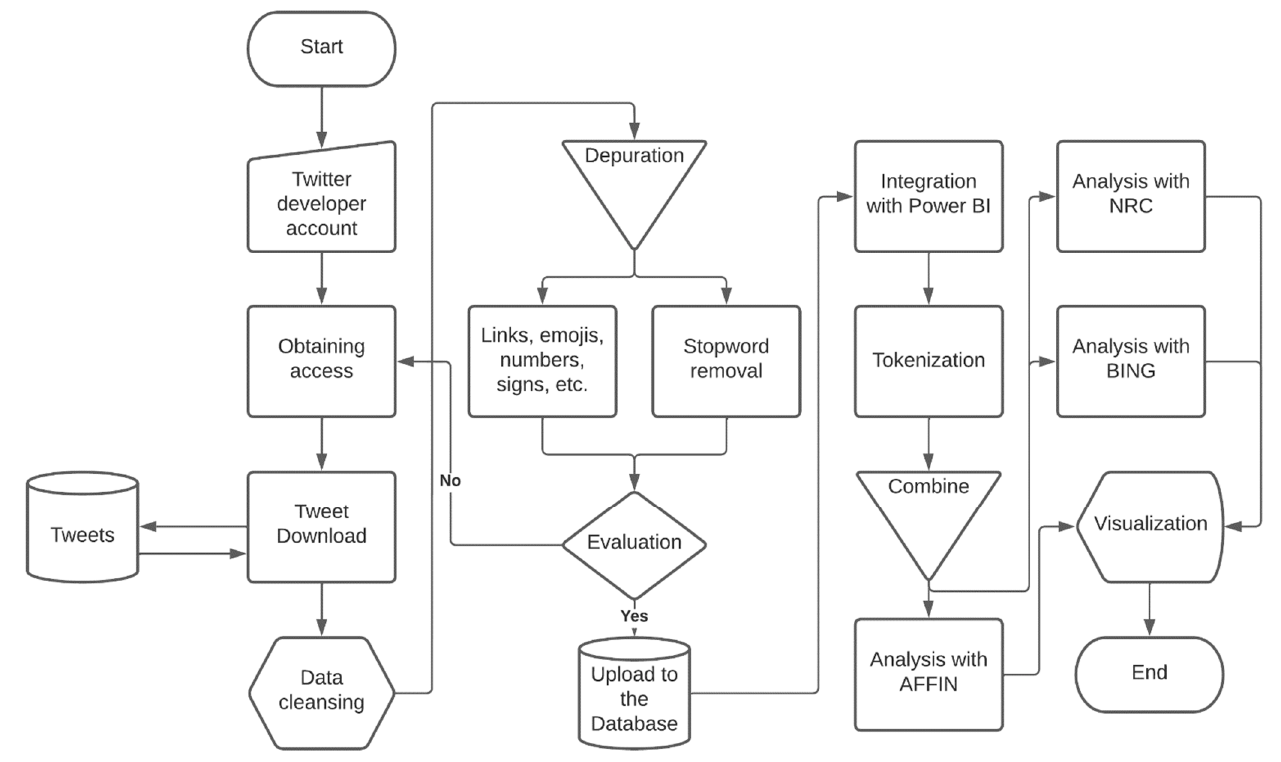
Figure 4. Flowchart for the application of sentiment analysis method to Twitter.